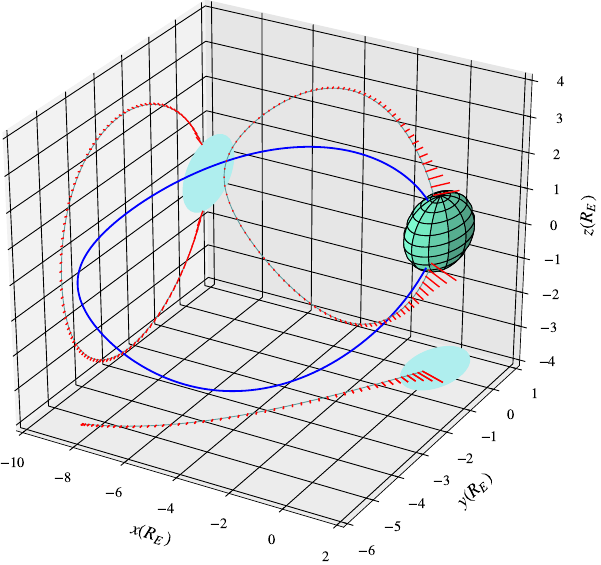
Figure 6. Field line trace (blue) and electric field mapping (red) in a Harris model with B eq = 3 . 4 × 10 4 nT, B 0 = 50 . 0nT and plasma sheet thickness d = 1 . 5 R E . The trace starts at 70 ◦ latitude, 03:00LT (local time), and 250km altitude. The projections of the mag- netic field line and the electric field vectors on the coordinate planes are also shown. Scale of electric field vector: 1 length unit = 35.4mVm − 1 .